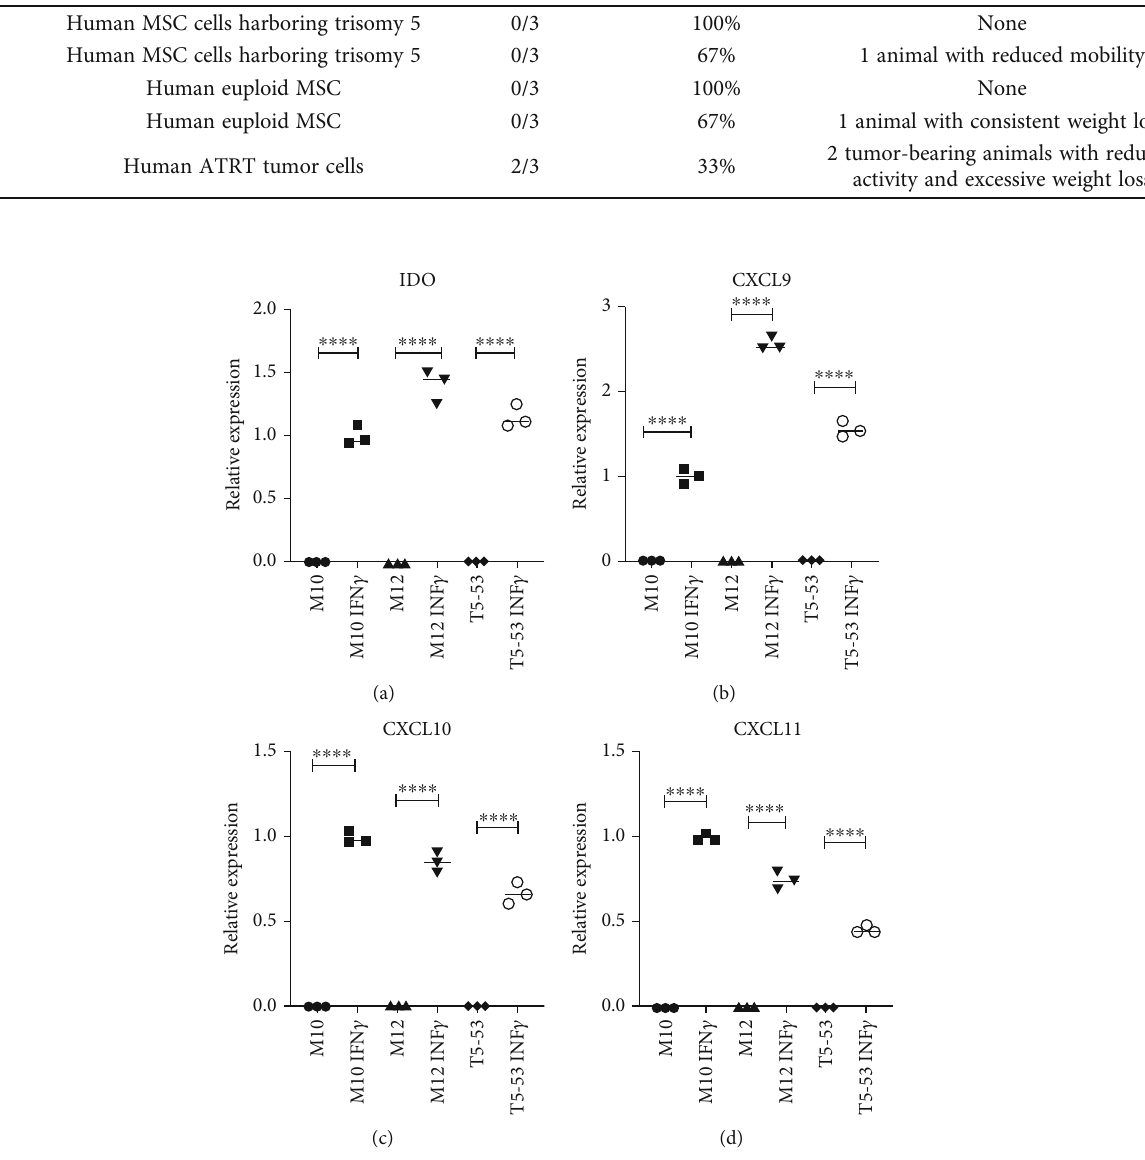
Figure 4: Relative expression of cytokines related to MSC immunomodulatory response, before and after stimulation by IFN- γ . (a) IDO mRNA relative expression. (b) CXCL9 mRNA relative expression. (c) CXCL10 mRNA relative expression. (d) CXCL11 mRNA relative expression. Values were normalized by GAPDH expression, using M10 IFN γ licensed as the reference sample. ∗∗∗∗ P < 0 : 0001 . M10 and M12: euploid human bone marrow MSC samples; T5-50 and T5-53: human bone marrow MSC samples with clonal trisomy